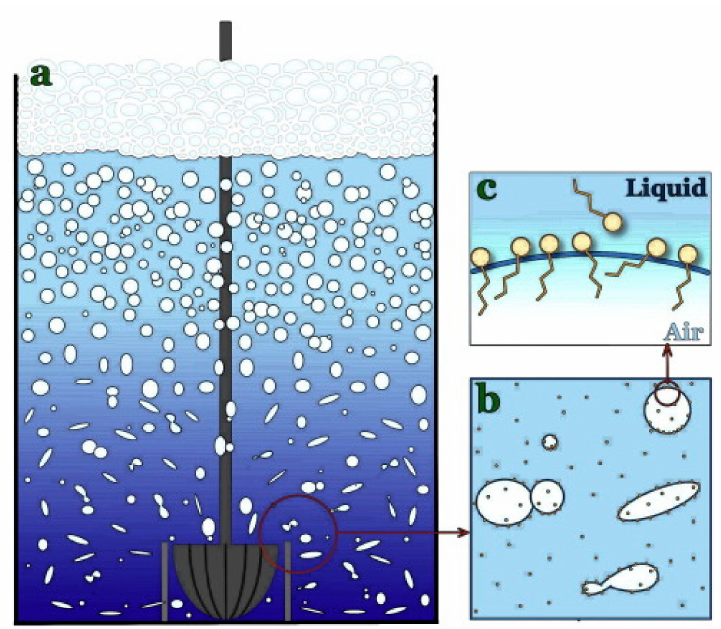
Figure 6. Relationship between scales in bubble behavior in flotation ( a ) macro-scale: cell level, ( b ) meso-scale: bubble coalescence and breakup studies, and ( c ) micro / nano-scale: molecular interactions